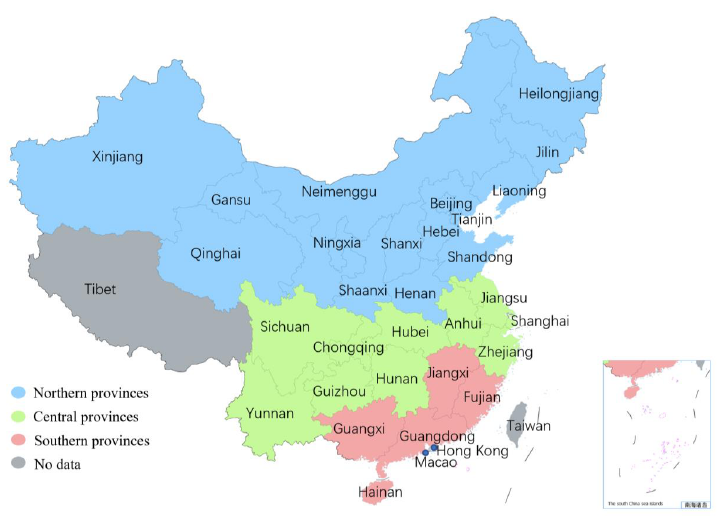
Figure 1. Map of China’s provincial divisions. Blue color denotes northern China, green color denotes central China, red color denotes southern China, and gray color denotes no data.